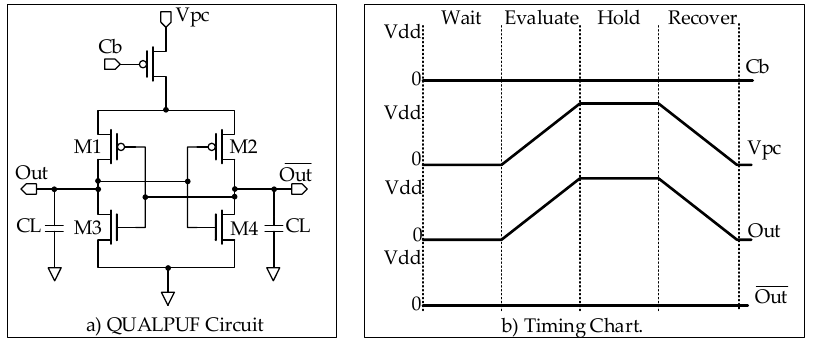
Figure 2. ( a ) QUALPUF circuit and ( b ) its timing chart.